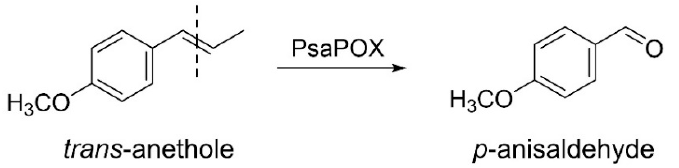
Figure 1. Alkene cleavage of trans -anethole into p -anisaldehyde by the dye-decolorizing peroxi- dase